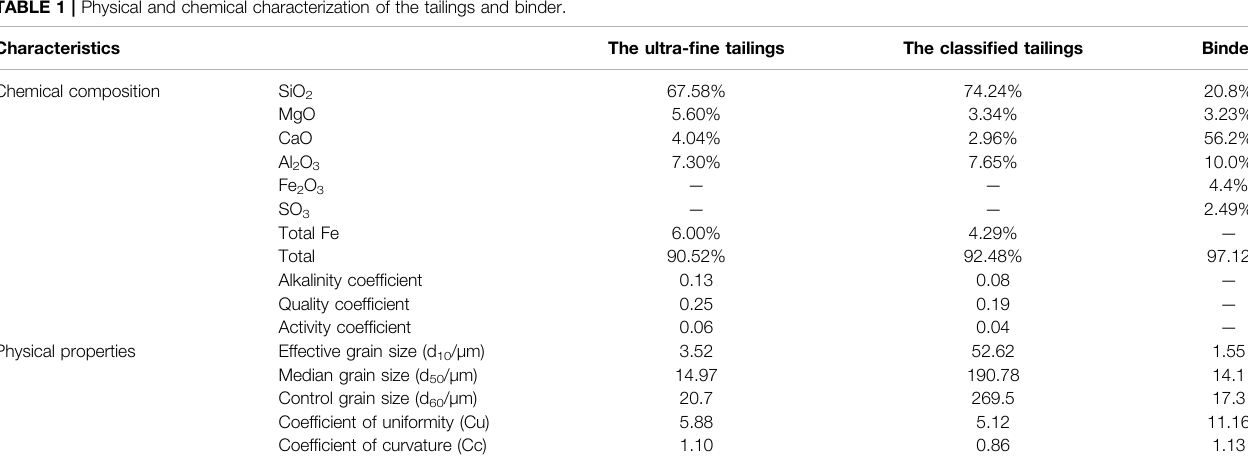
TABLE 1 | Physical and chemical characterization of the tailings and binder.